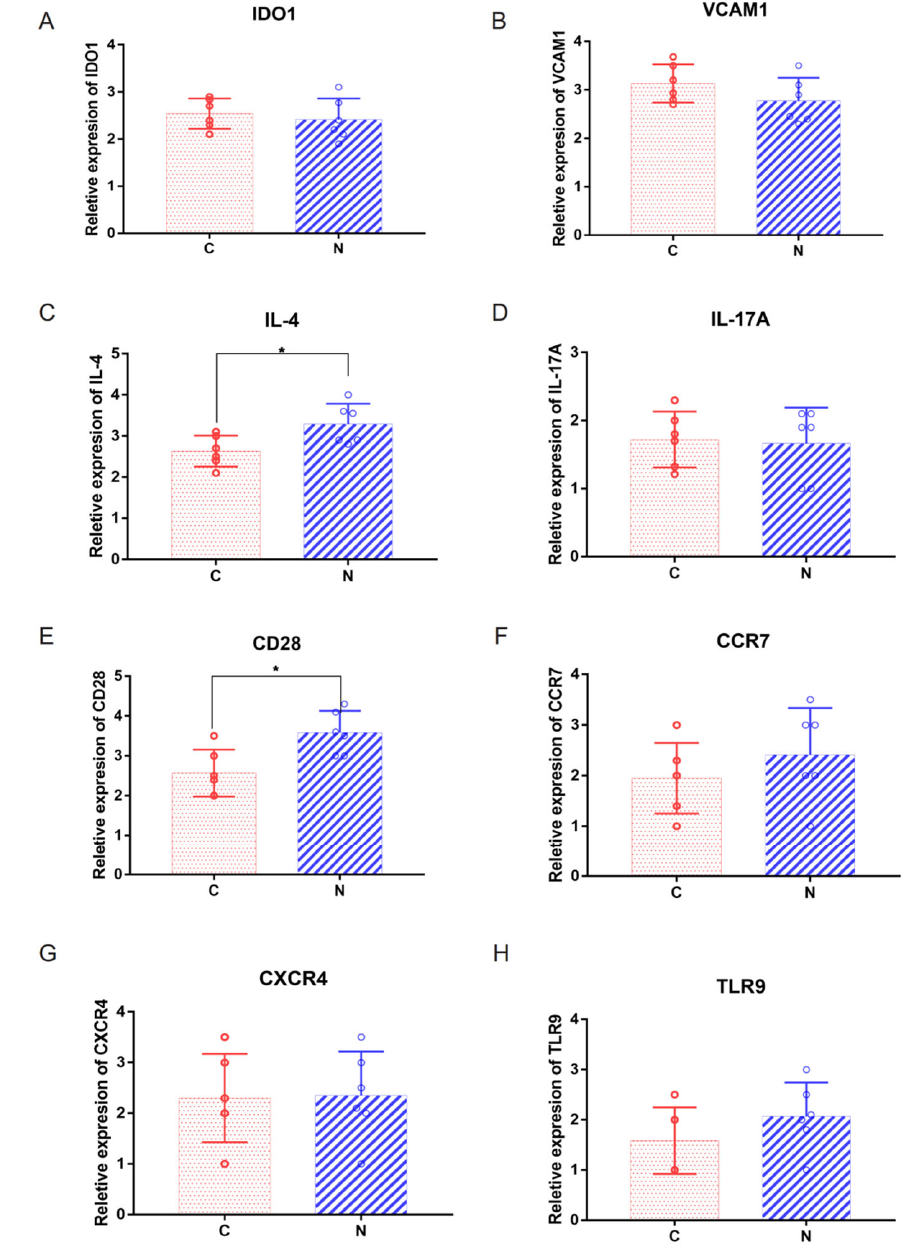
Figure 5. ( A – H ) Relative expression levels of IDO1, VCAM1, IL-4, IL-17A, CD28, CCR7, CXCR4 and TLR9 by RT–qPCR analysis. * p < 0.05, Group N compared C.